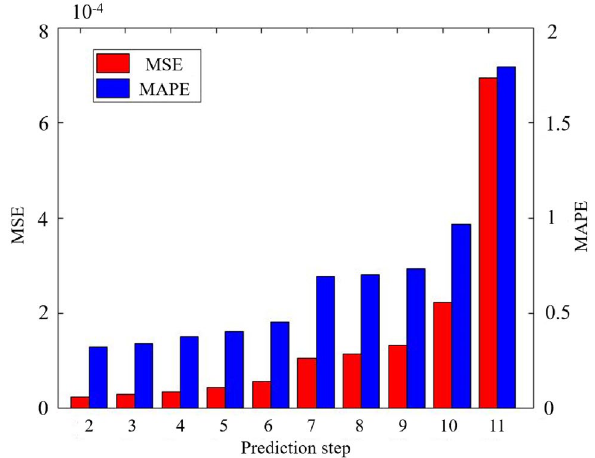
Fig. 13 The maximum prediction step of different algorithms under different working